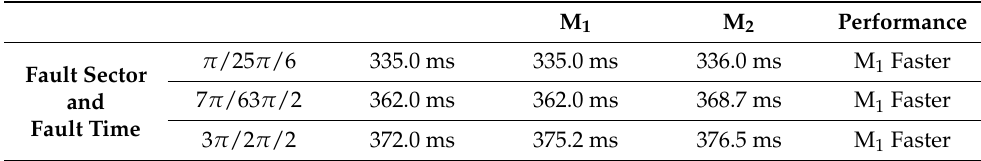
Table 6. Comparison of fault diagnosis results between M1 and M2.